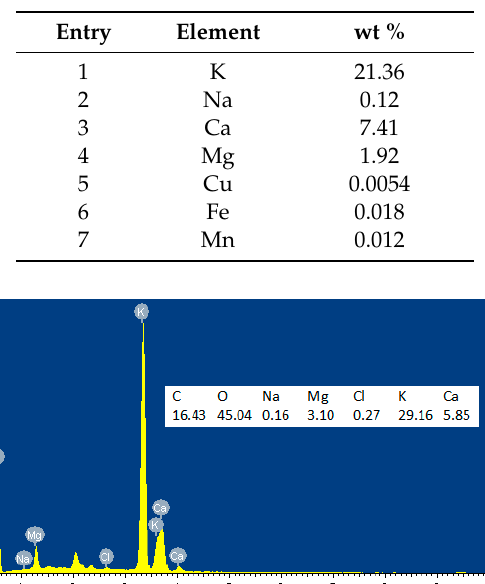
Figure 2. pH values of AWEs. Table 1. ICP-AES analysis of the pomelo peel ash.